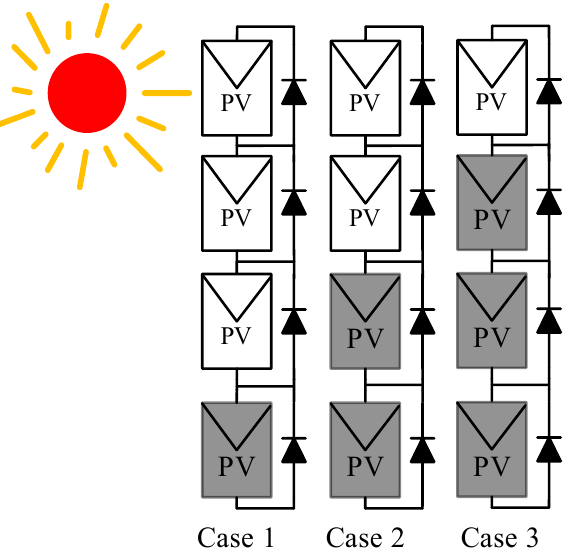
Figure 5. Topological structure of PV array at PSC.